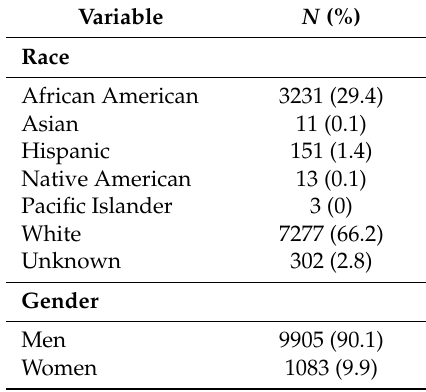
Table 2. Population